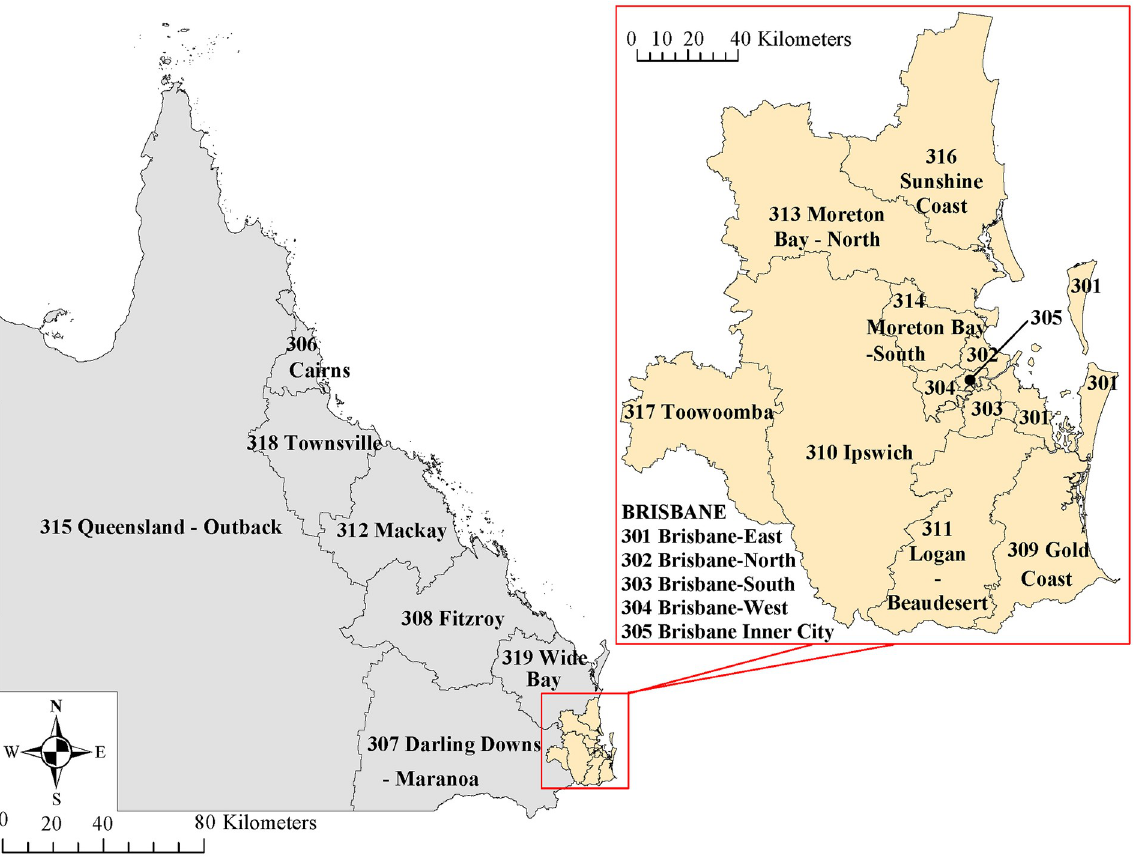
Fig 1. Map of Queensland divided into statistical areas level